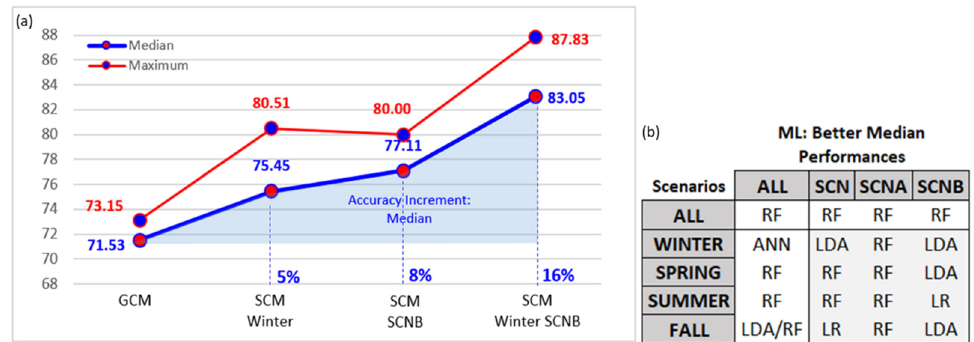
Figure 9. ( a ) Median accuracies (blue line) and maximum accuracies (red line), indicating the incre- ment of performance for the best algorithms and parameters. ( b ) Better ML algorithm per scenario.